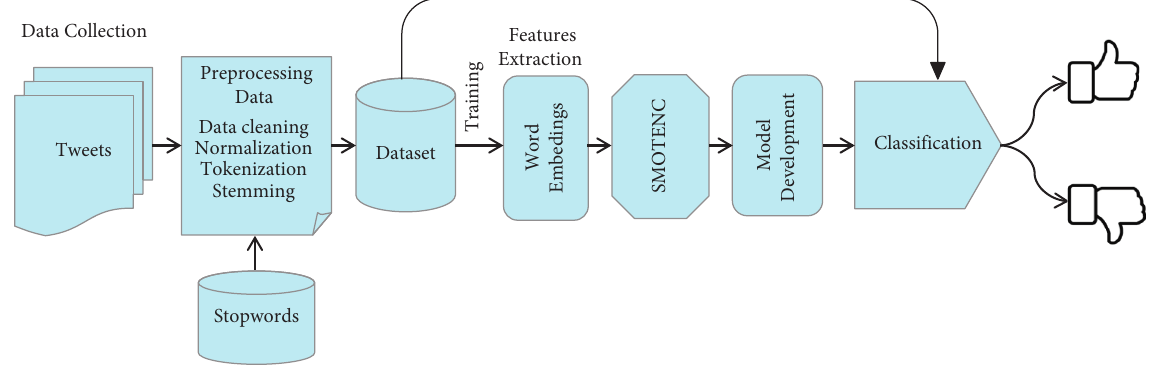
Figure 1: The proposed ASA model.